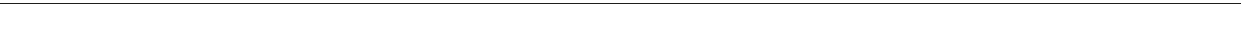
Fig. 4 Stau1 inhibits neurogenesis in a Klf4-dependent manner. a (Upper) Immunostaining with Tuj1 (green) or Map2 (red) antibodies in NPCs infected with pLKO.1-shScramble or pLKO.1-shStau1 (#1 and #3) lentivirus. DAPI (blue). Scale bars, 25 μ m. (Lower left) Stau1, Stau2, and α -tubulin in samples analyzed in a were were detected by immunoblotting ( n = 2). See also Supplementary Fig. 8a. (Lower right) Corresponding quanti fi cation of number of Tuj1 + and Map2 + cells. b (Upper) Immunostaining with Nestin or Ki67 (both red) antibodies of samples analyzed in a . DAPI (blue). Scale bars, 50 μ m. (Lower) Corresponding quanti fi cation of Nestin + ( n = 3) and Ki67 + ( n = 2 or 3) cells. c (Upper) Immunostaining of NPCs infected with pCDH-control or pCDH-Stau1 lentivirus with Tuj1 (green) or MAP2 (red) antibodies. DAPI (blue). Scale bars, 25 μ m. (Lower left) Stau1 and α -tubulin in samples analyzed in c were detected by immunoblotting ( n = 2). (Lower) Corresponding quanti fi cation of data shown above. d (Upper) Immunostaining of samples equivalent to those shown in c with Nestin or Ki67 (both red) antibodies. DAPI (blue). Scale bars, 25 μ m. (Lower) Corresponding quanti fi cation of Nestin + ( n = 3) and Ki67 + (Ctrl, n = 3; Stau1, n = 2) cells. e RT-qPCR of indicated transcripts in control- or Klf4-overexpressing NPCs infected with pLKO.1-shScramble or pLKO.1-shStau1 lentivirus cultured for 0.2 or 2 days in differentiation conditions ( n = 3). f RT-qPCR of indicated transcripts in control- or Stau1- overexpressing NPCs infected with pLKO.1-shScramble or pLKO.1-shKlf4 lentivirus cultured for 0.2 or 2 days in differentiation conditions ( n = 3). Data are shown as mean ± SD. ANOVA tests were performed to calculate statistical signi fi cance (* P < 0.05, ** P < 0.005, *** P < 0.0005). See